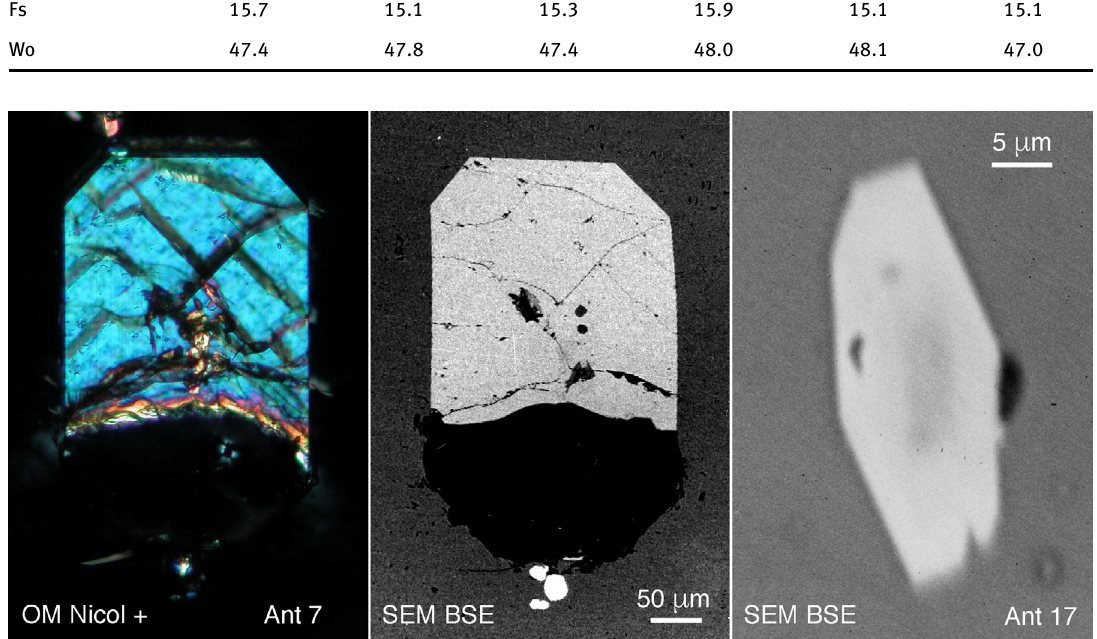
Figure 5. Left and center: Optical microscopy photographs of a diopsidic pyroxene present in the glass of the Antiparos obsi- dian (sample Ant 7. Nicol +) and the same crystal photographed with the SEM using a back scattered electron detector. Right: image of an amphibole (sample Ant 7. SEM BSE) with skeletal